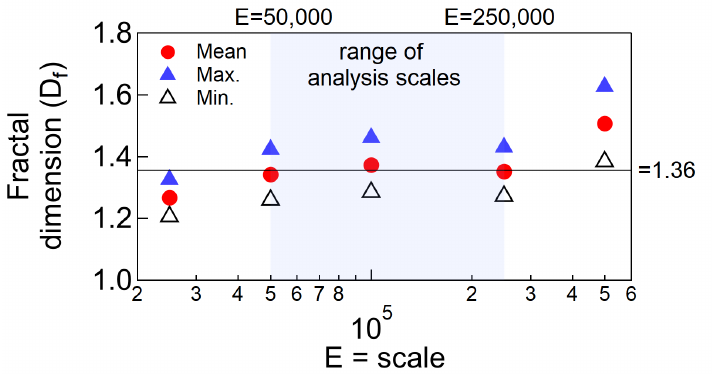
Figure 4. Variability of D f for different map scales E . This referential plot corresponds to Chillán (#10 in Table 1). Minimum, average and maximum values of this parameter were included for reference. The horizontal line is a global